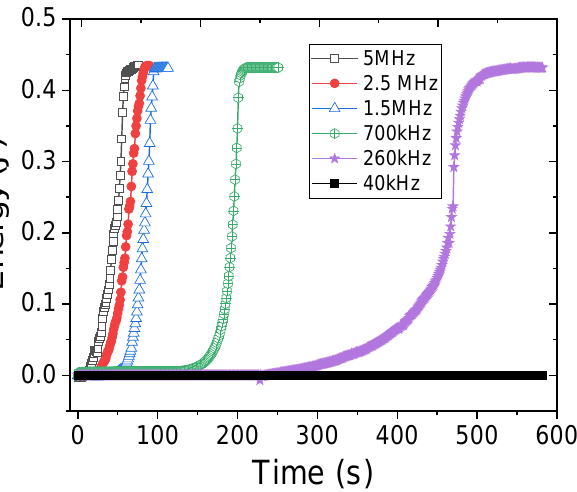
Figure 3. Ultrasound energy absorption during actuation of 1 wt% PNIPAM solution in different frequencies.